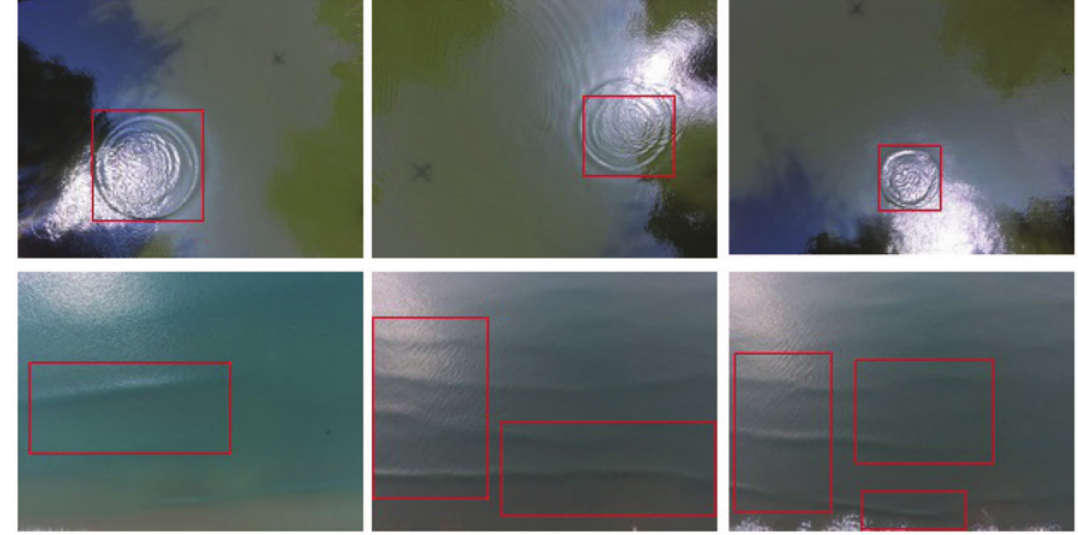
Figure 7: Detection examples with internal waves detection framework based on PCANet.